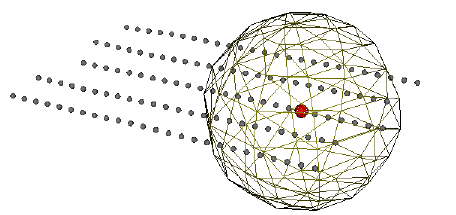
Figure 1: Neighbourhood selected for a given aeroplane station . Projection centers inside the sphere will be used to evaluate a connectivity graph.